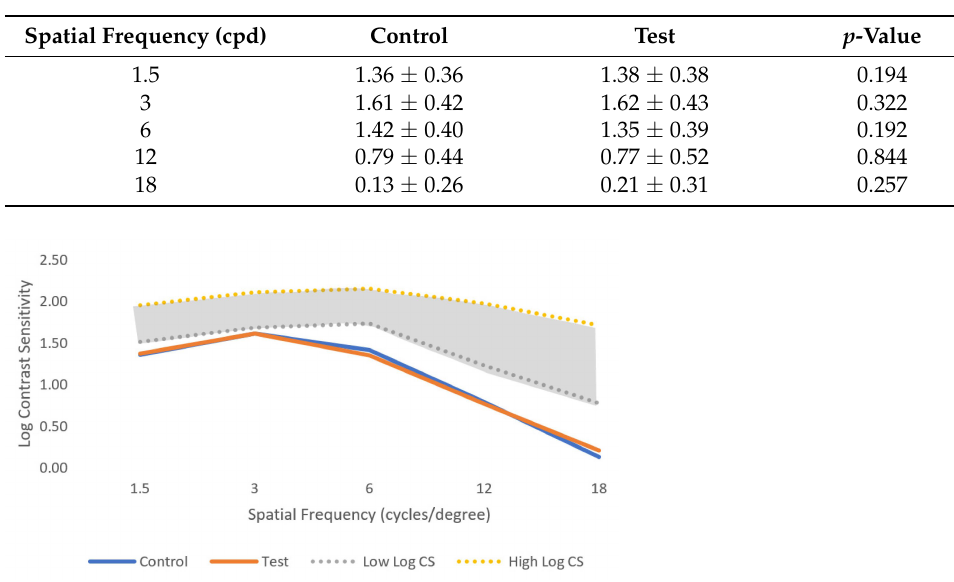
Table 3. Mean ± standard deviation of log visual contrast sensitivity for five spatial frequencies, for both control and test conditions. All p -values were calculated using the Wilcoxon test.